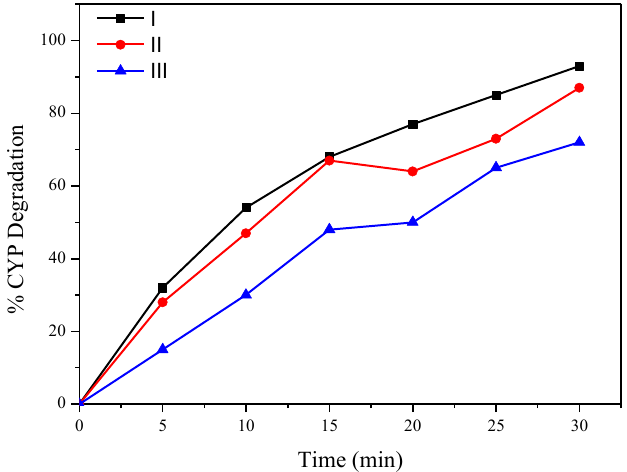
Figure 7. Reusability of recovered Mg (OH) 2 for catalytic ozonation.